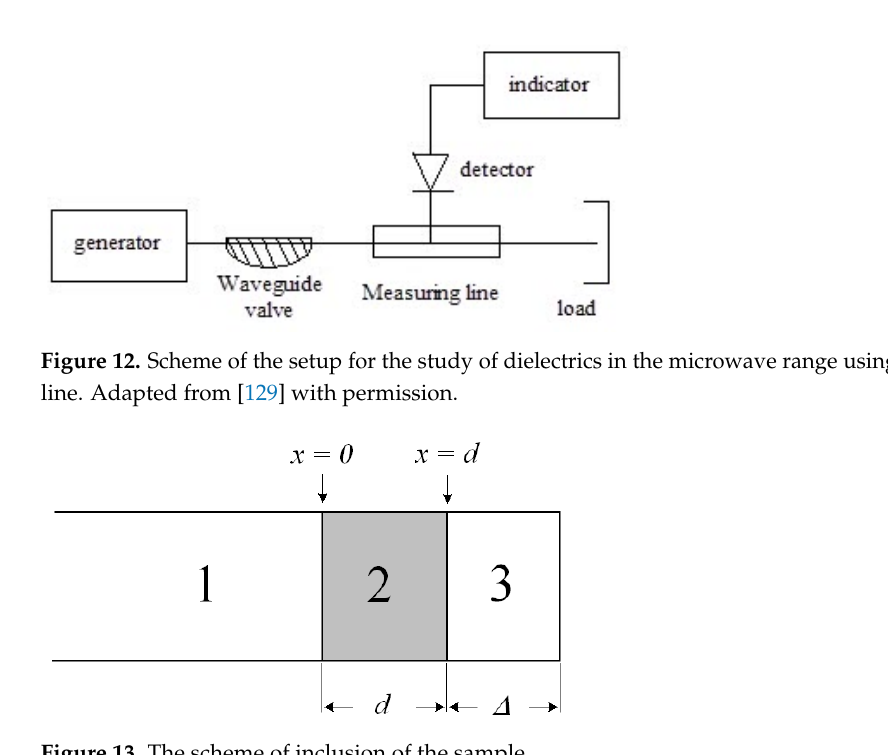
Figure 13. The scheme of inclusion of the sample.